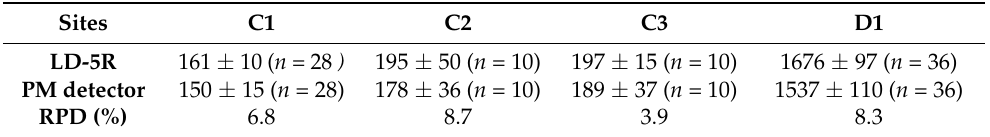
Table 2. Comparison of average PM 2.5 concentrations measured between self-developed PM